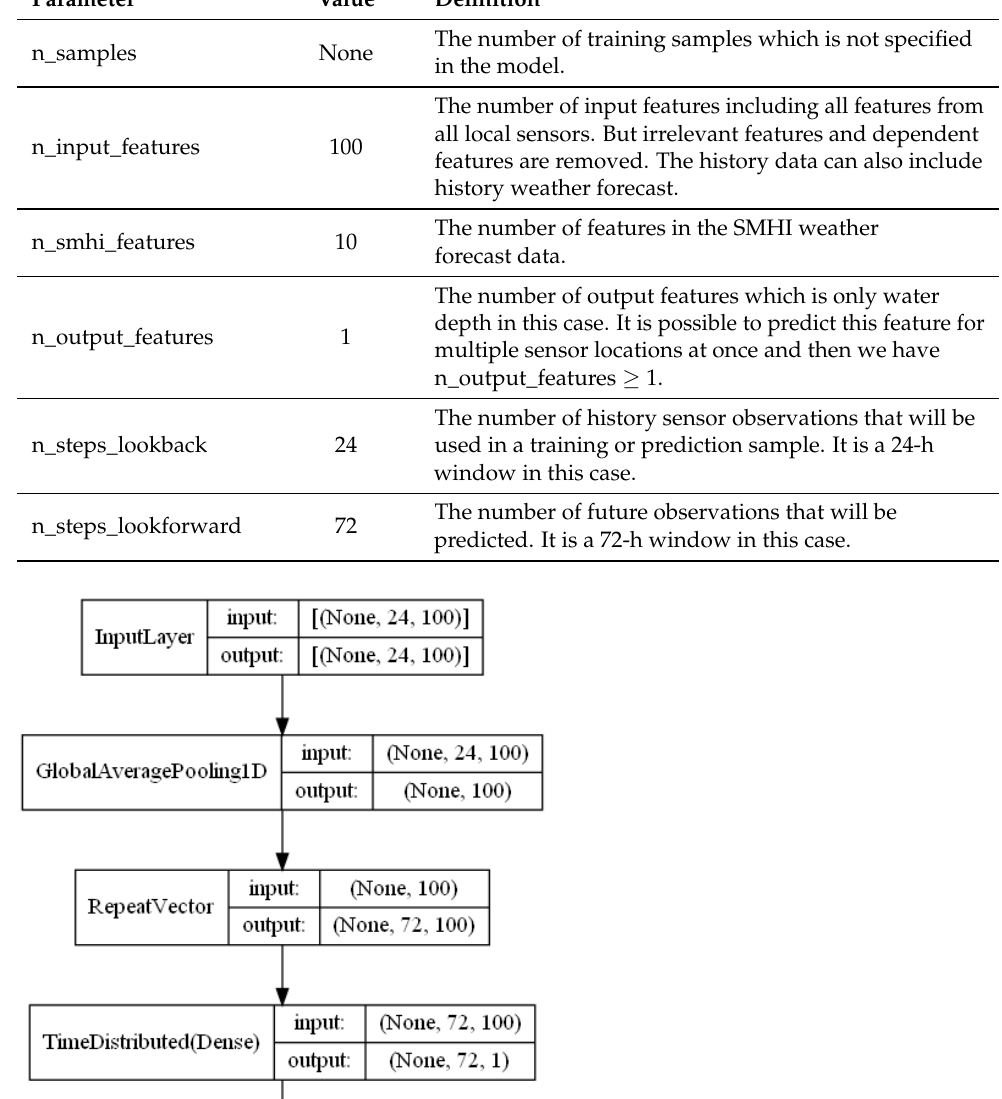
Table 1. Parameter values used in our model description (only for illustration purpose). These parameter values can be different from the ones used in Section 6.